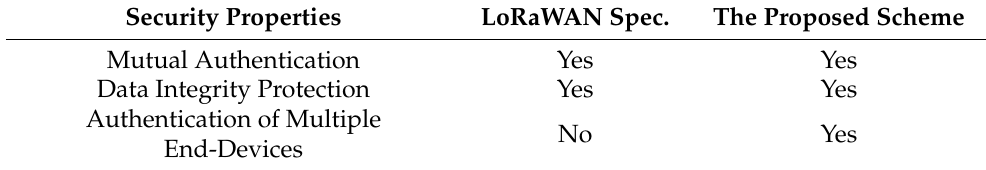
Table 2. Functionality comparison.